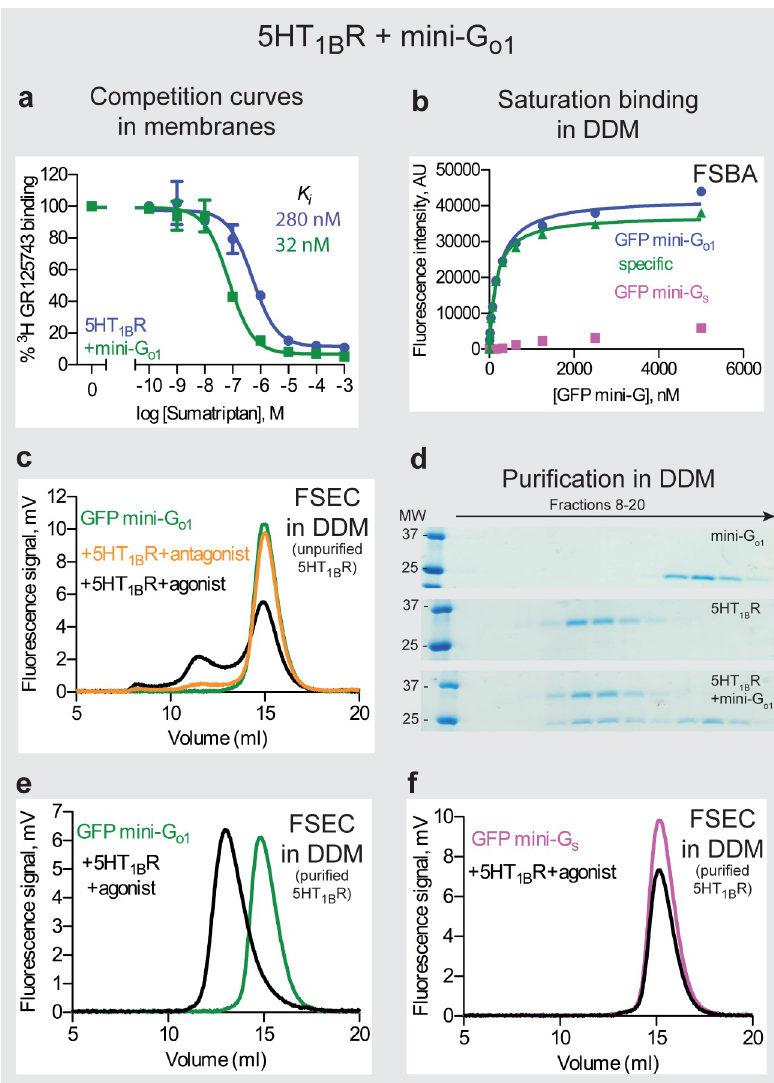
Fig 7. The 5HT 1B R − mini-G o1 complex. ( a ) Competition bindingcurves were performedon membranes in duplicate (n = 2) by measuringthe displacement of the antagonist 3 H-GR125743with increasing concentration of the agonistsumatriptan(apparent K i valuesrepresenting mean ± SEM are in parentheses): blue circles, 5HT 1B R ( K i 280 ± 10 nM); green squares,5HT 1B R and mini-G o1 ( K i 32 ± 3 nM). Error bars representSEM. ( b ) Measurement of GFP-mini-G o1 affinity to DDM-solubilized, donitriptan-bound5HT 1B R usingthe FSBA: blue circles, 5HT 1B R and GFP-mini-G o1 (total binding); purplesquares, 5HT 1B R and GFP-mini-G s (non-specific binding); green triangles,specific binding.The apparent K D value (180 ± 24 nM) represents mean ± SEM of two independent experiments. Curvesshown are from a representative experiment. ( c )FSEC traces of GFP- mini-G o1 with DDM-solubilizedunpurified5HT 1B R boundto the following(retentionvolumesare shownin parentheses): orange, the antagonistSB224289(14.9 ml); black, the agonistdonitriptan(11.3 ml and14.9 ml). Free GFP-mini-G o1 (green)resolvedas a predominant peak with a retentionvolumeof 14.9 ml ( d ) Mini-G o1 forms a complexwith purified5HT 1B R. The three panelsare coomassie blue-stained SDS-PAGE gels of fractions from 3 separate SEC experiments: top panel,mini-G o1 ; middlepanel, 5HT 1B R; bottom panel,mini- G o1 mixed with donitriptan-bound5HT 1B R (1:1 molar ratio). ( e ) FSEC traces of GFP-mini-G o1 with purified 5HT 1B R: black, GFP-mini-G o1 with 5HT 1B R purifiedin DDM (13 ml); green, GFP-mini-G o1 (14.8 ml). ( f ) FSEC traces of GFP-mini-G s with purified5HT 1B R: black, GFP-mini-G s with 5HT 1B R purifiedin DDM (negative control; 15.1 ml); purple,GFP-mini-G s (15.1 ml). Retentionvolumesare shownin parentheses.